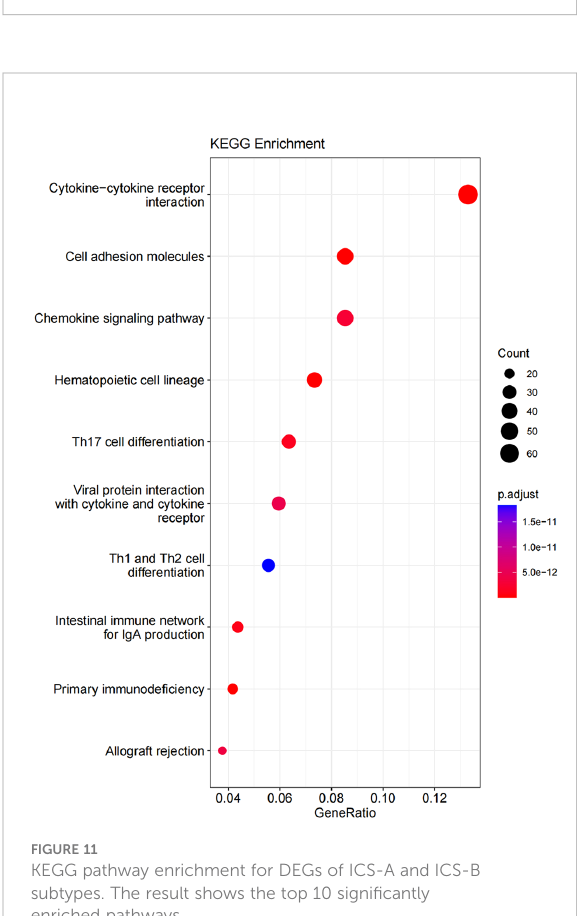
FIGURE 10 Gene ontology term enrichment for DEGs of ICS − A and ICS − B subtypes. The result shows the top 10 signi fi cantly enriched terms on the BP, CC, and MF.